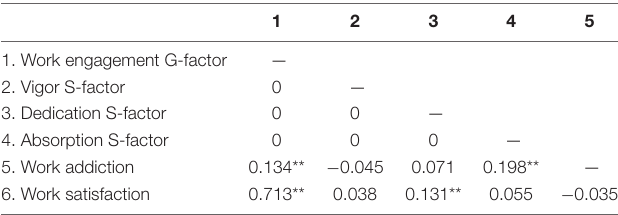
TABLE 4 | Spearman Bivariate correlations between variables used in Sample 2 ( N =